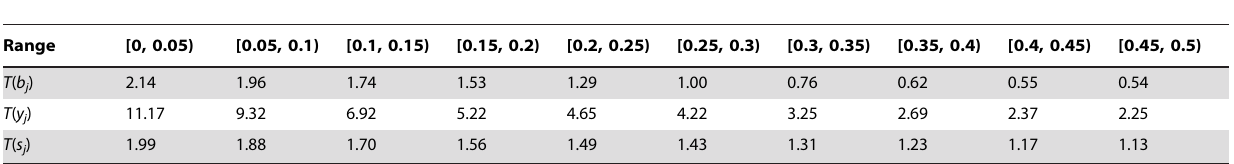
Table 3. The m/z error discriminability of b-ions ( T ( b j ) ), y-ions ( T ( y j ) ) and the six types (b, b-H 2 O, b-NH 3 , y, y-H 2 O and y-NH 3 ) of theoretical ions ( T ( s j )